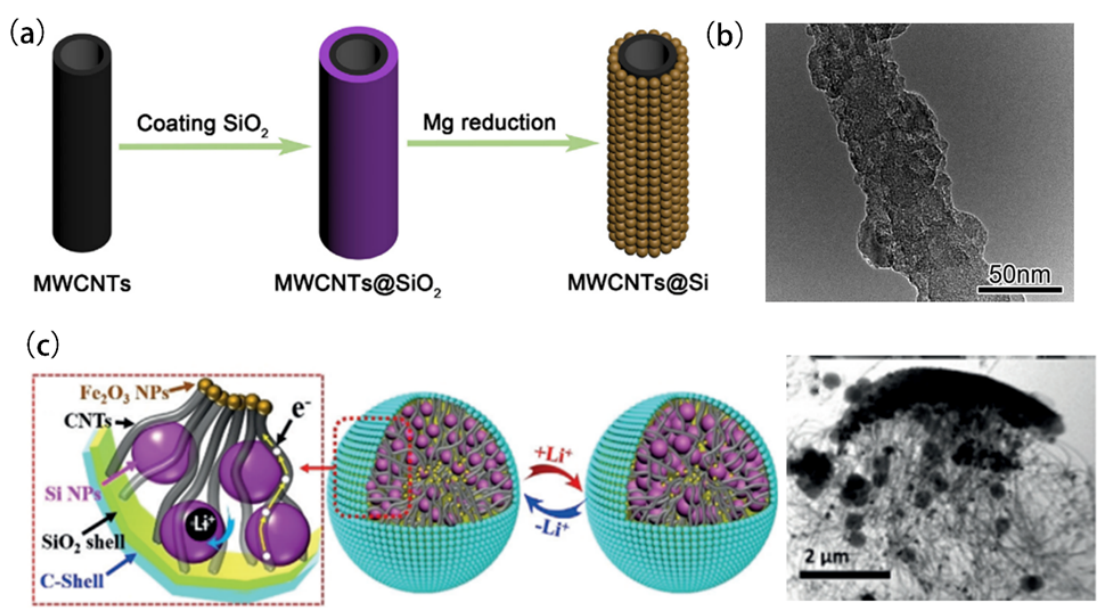
Figure 7. ( a ) Schematic diagram of synthetized MWCNTs@Si composite material. ( b ) TEM images of MWCNTs@Si composite material [18]. ( c ) 3D view and TEM image of CNT/Si/SiO 2 /C composite material [47]. Reprinted with permission from [18]. Copyright 2015 Elsevier. Reprinted with permission from [47]. Copyright 2019 John Wiley and